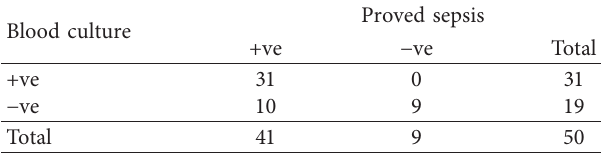
Table 5: Comparison of PCR results with proved sepsis.